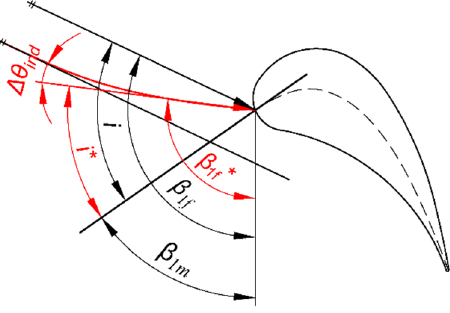
Figure 2. Explanation of induced incidence.